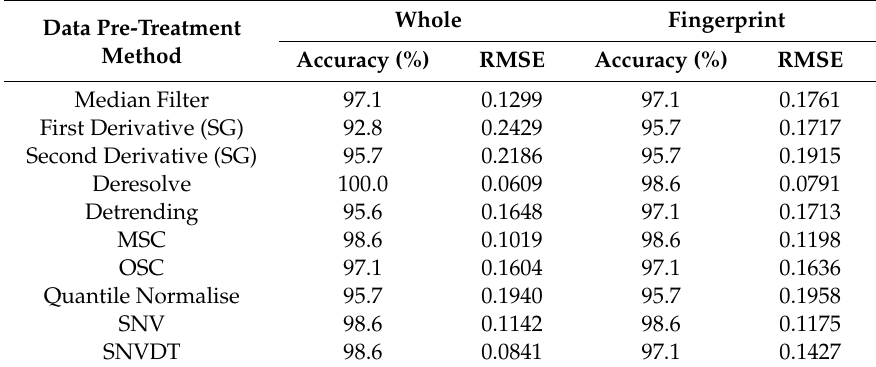
Table 2. Summary of FF-ANN Model performance with no variable selection on the ‘whole’ spectrum and on fingerprint region only.